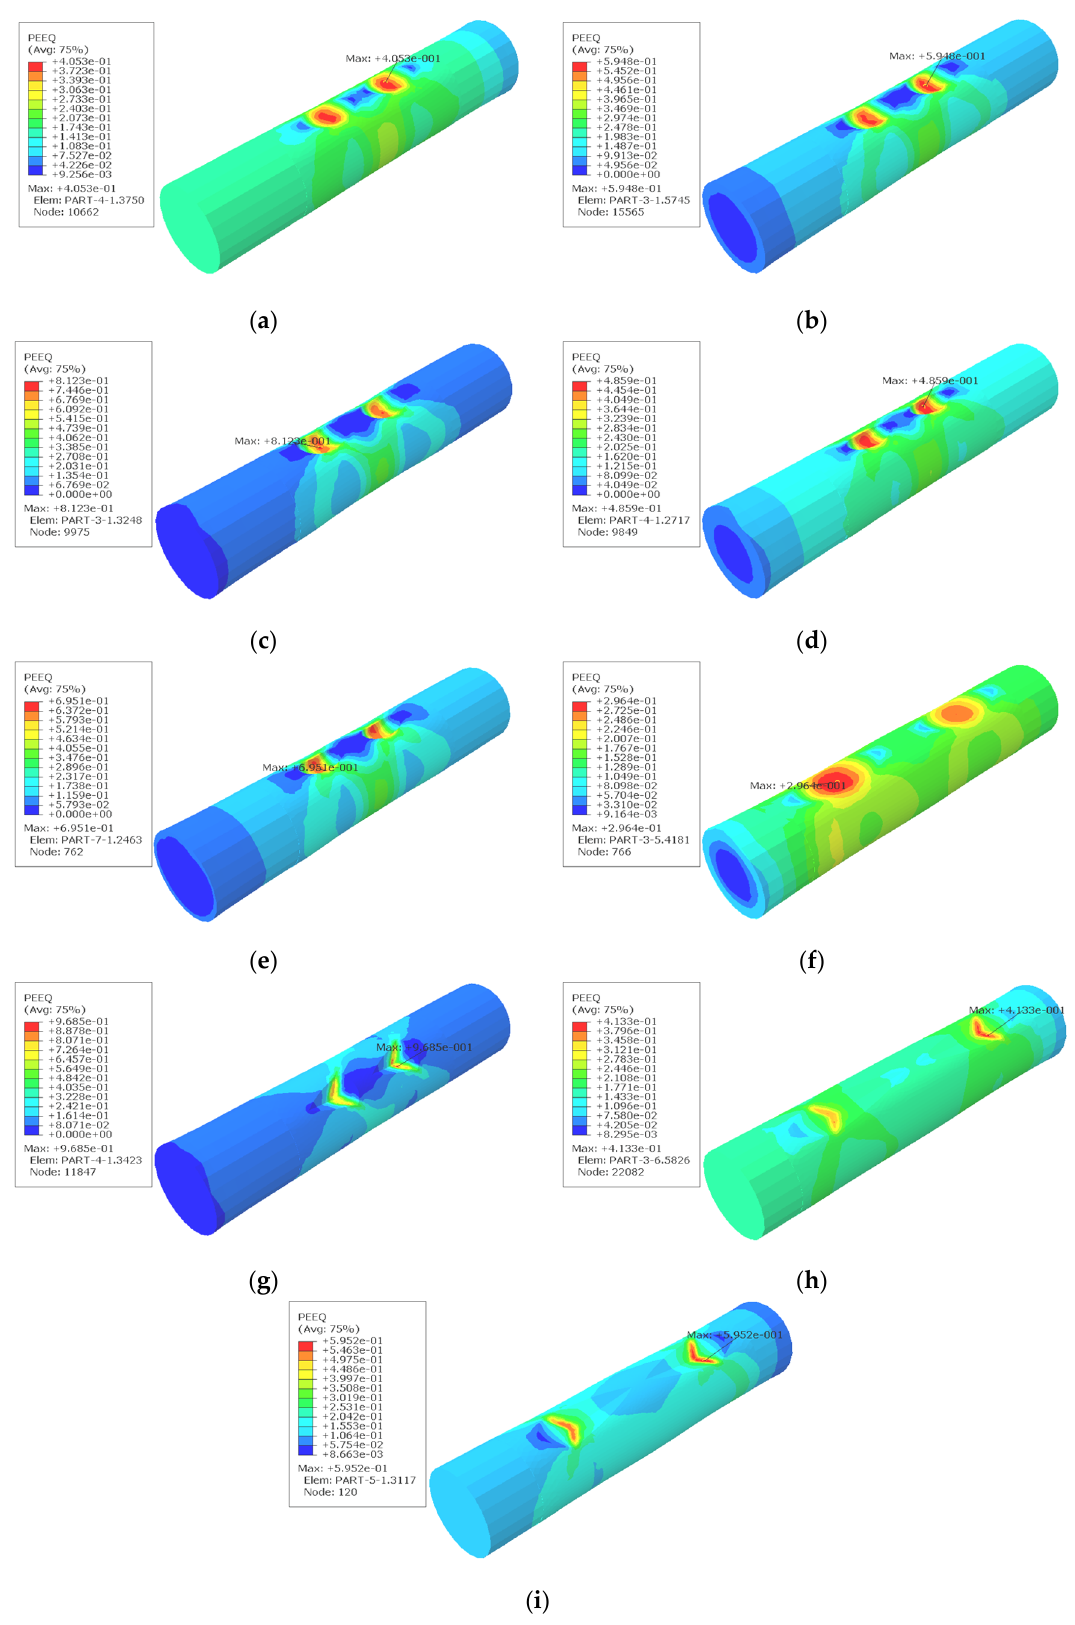
Figure 9. Results of equivalent plastic strains (PEEQ) obtained from FEA based on Table 6: ( a ) 1#; ( b )